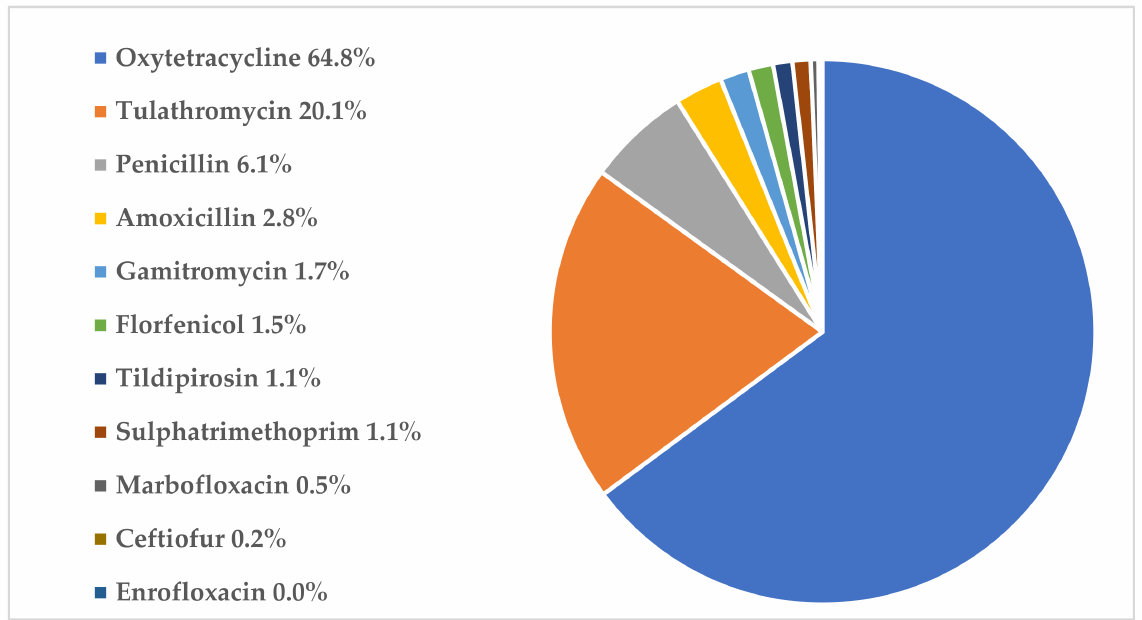
Figure 1. Proportions of antibiotic treatments administered during follow-up according to the active substance. All treatments were given individually to the calves using parenteral administration (topical treatments excluded, n = 132, 0.4% of all antibiotic